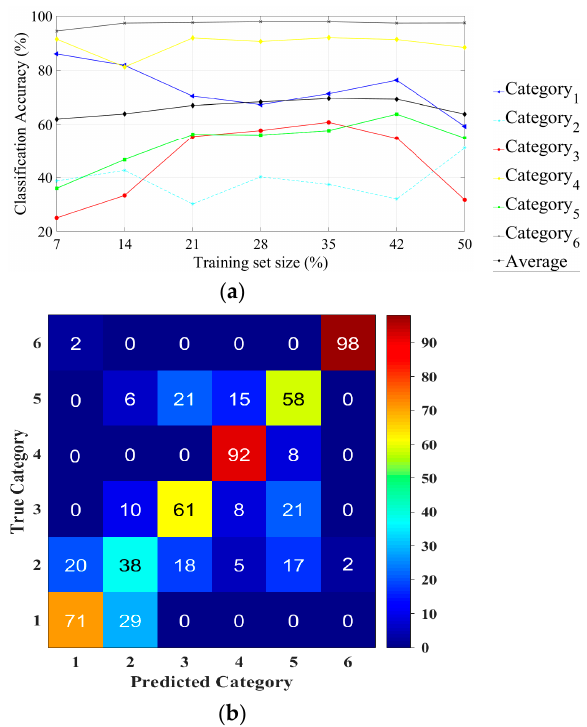
Figure 24. The topographies classification performance of the multiscale HP data set: ( a ) the effect of increasing the training set size on the classification accuracy and ( b ) a confusion matrix for six surface category classifications by using 35% of the HP data set for training.